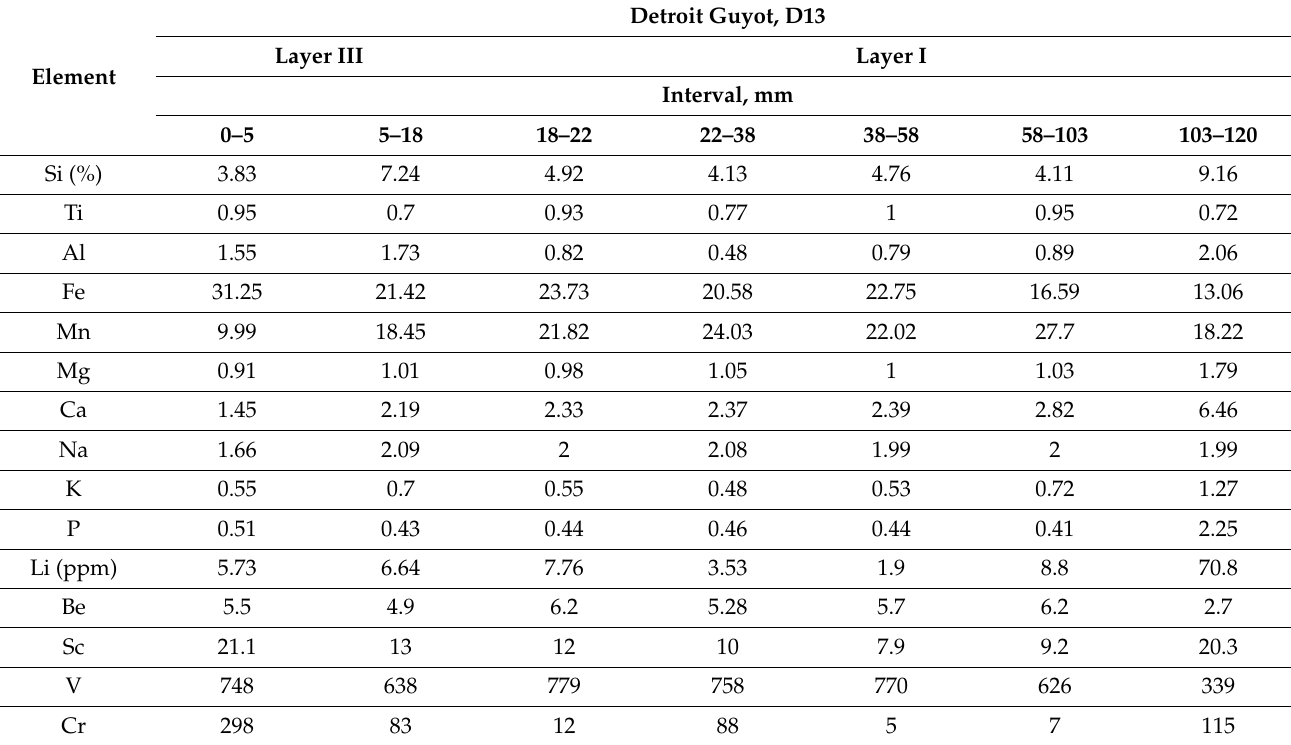
Table 3. Chemical composition and growth rates of ferromanganese